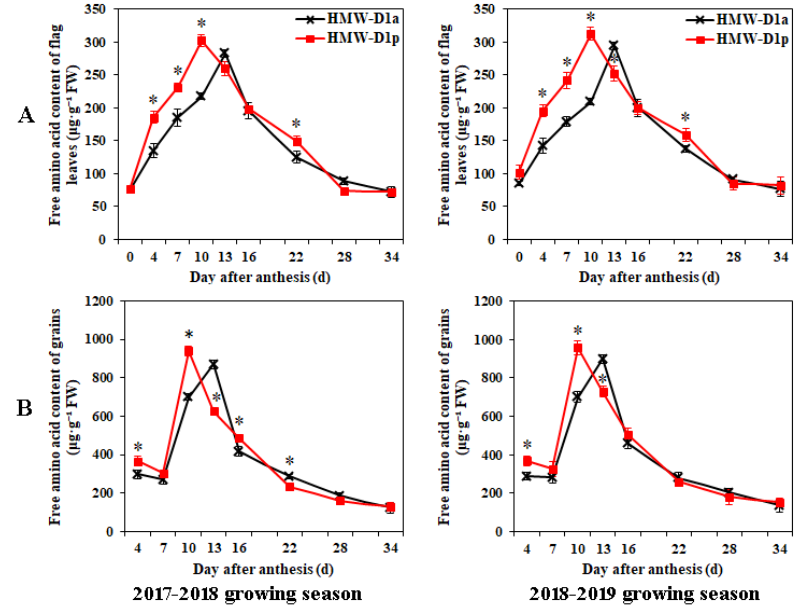
Figure 5. Content of total free amino acids in flag leaves ( A ) and grains ( B ) from HMW-D1a and HMW-D1p over two growing seasons, 2017–2018 (left) and 2018–2019 (right). Red and black lines represent the HMW-D1p and HMW-D1a, respectively. * indicates significant di ff erence at same developing stage of the two materials ( p < 0.05).